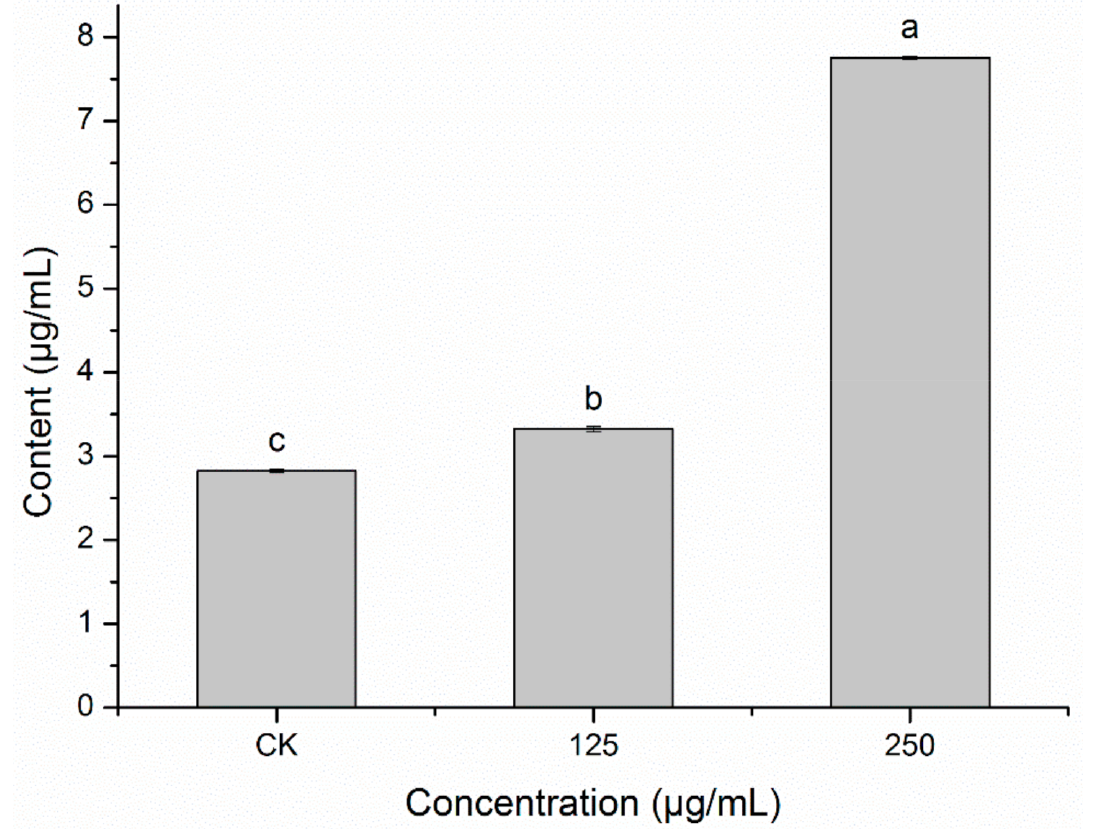
Figure 10. Pyruvic acid content effect of HBA against A. avenae subsp. citrulli . Note: Columns followed by different letters indicate significantly different scores in the same phase according to Duncan’s multiple range tests at the p < 0.05 significance